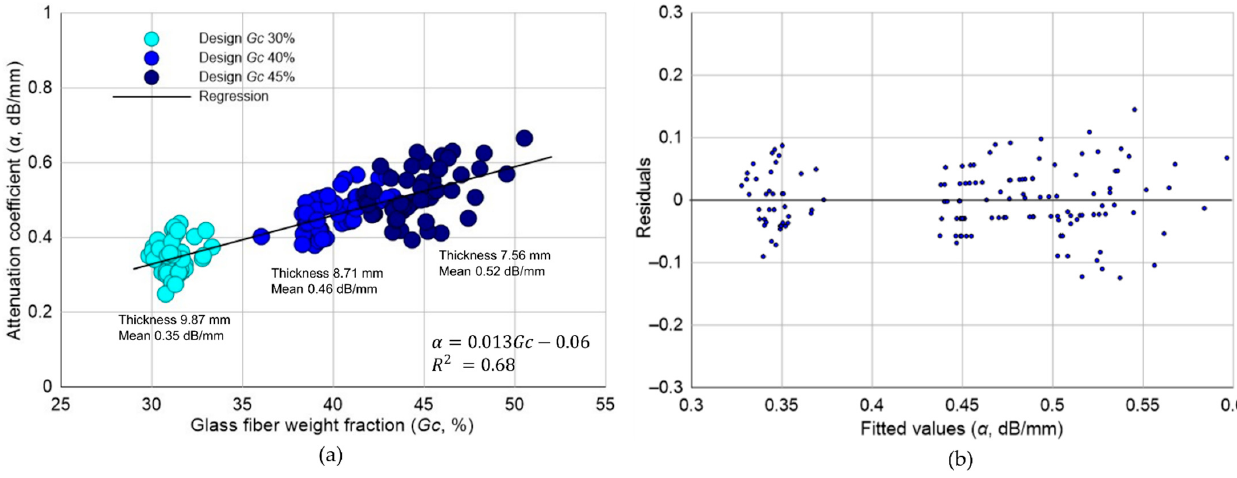
Figure 7. Ultrasonic wave attenuation as a function of the Gc . ( a ) Regression analysis results. ( b ) Residual analysis results.